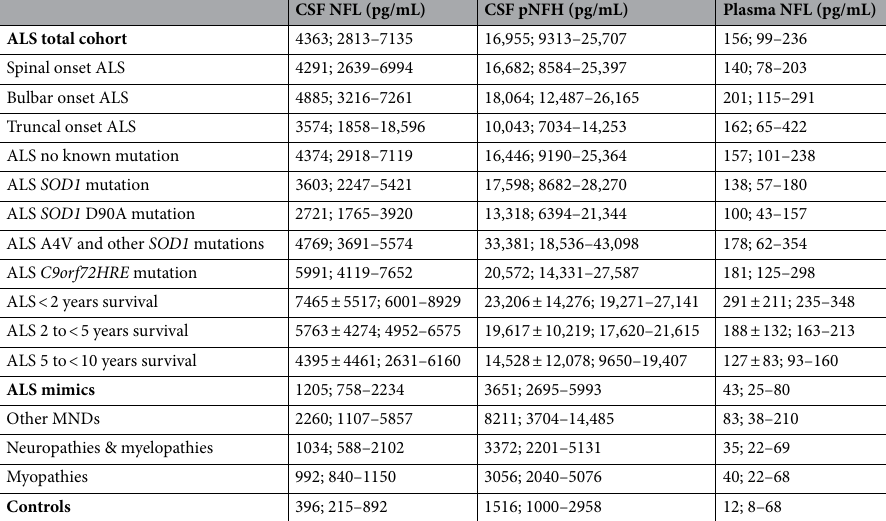
Table 2. Concentrations of CSF NFL, CSF pNFH and plasma NFL in ALS patients. Patients were grouped according to their regions of symptom onset and genotype. ALS mimics are divided into the following groups: other MNDs, neuropathies & myelopathies and myopathies. Biomarker estimates for diagnosis groups are presented as the median; Q1–Q3 and biomarker estimates for ALS survival groups are presented as the arithmetic mean ± SD; 95%